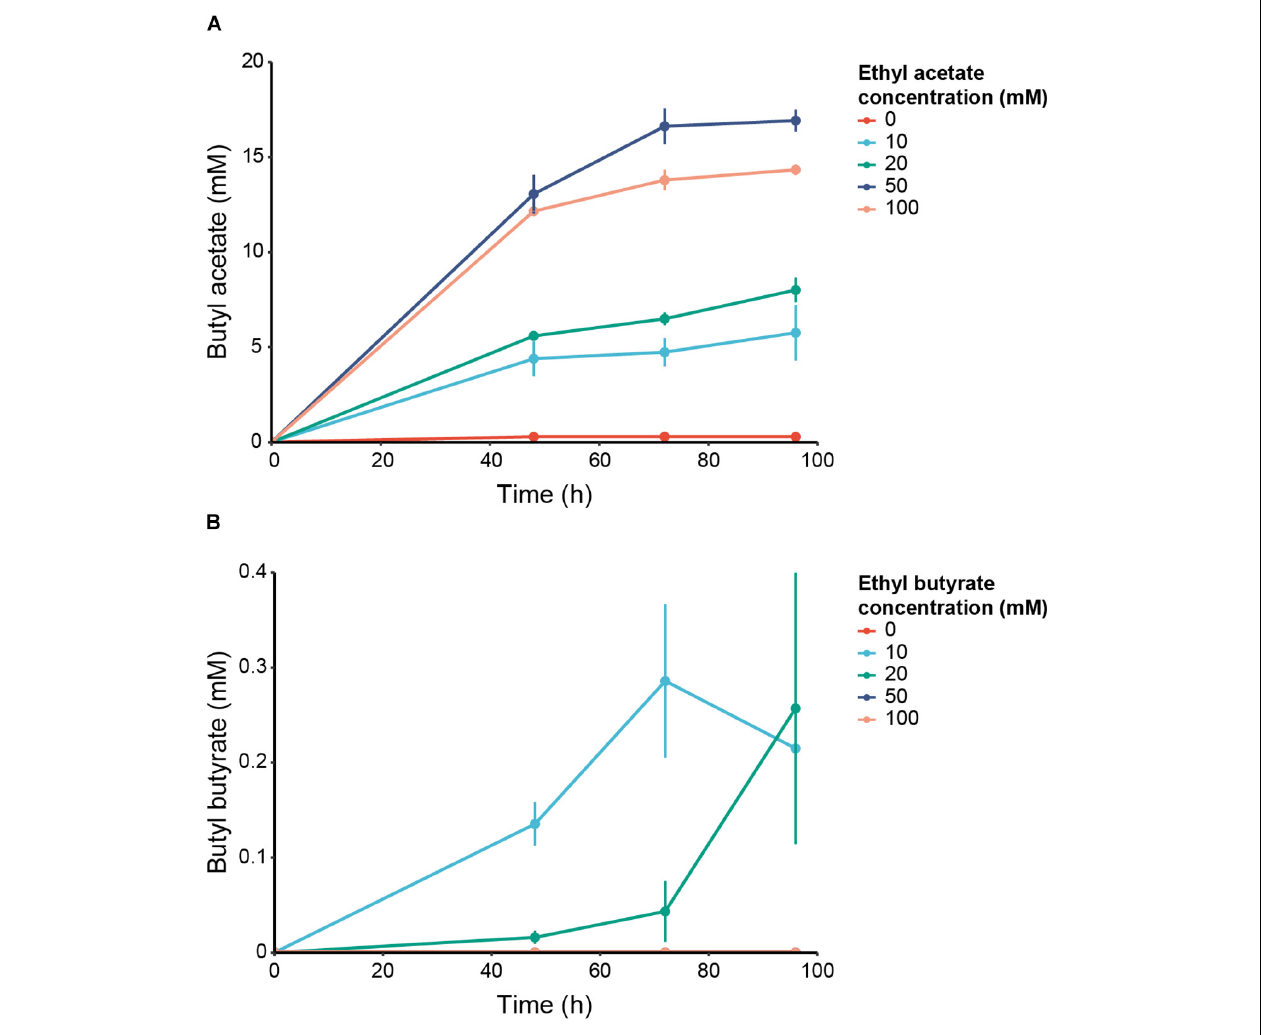
FIGURE 5 | In vivo alcoholysis in engineered C. beijerinckii . (A) Production of butyl acetate by C. beijerinckii expressing WT WanEat1 and grown in 0 (red), 10 (light blue), 20 (green), 50 (dark blue) or 100 mM (orange) ethyl acetate. (B) Production of butyl butyrate by C. beijerinckii expressing WT WanEat1 and grown in 0 (red), 10 (light blue), 20 (green), 50 (dark blue), or 100 mM (orange) ethyl butyrate. Error bars indicate the standard